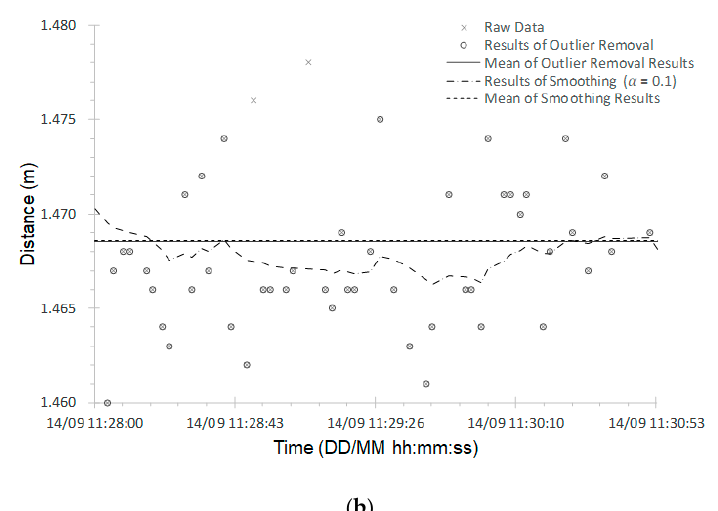
Figure 11. Comparison of raw data, outlier removal result, and smoothing result of water level data measured by ultrasonic sensor in downstream bridge for hydrograph 1. ( a ) Comparison section from 14/09 11:16 to 14/09 11:31; ( b ) comparison section from 14/09 11:28 to 14/09 11:31.